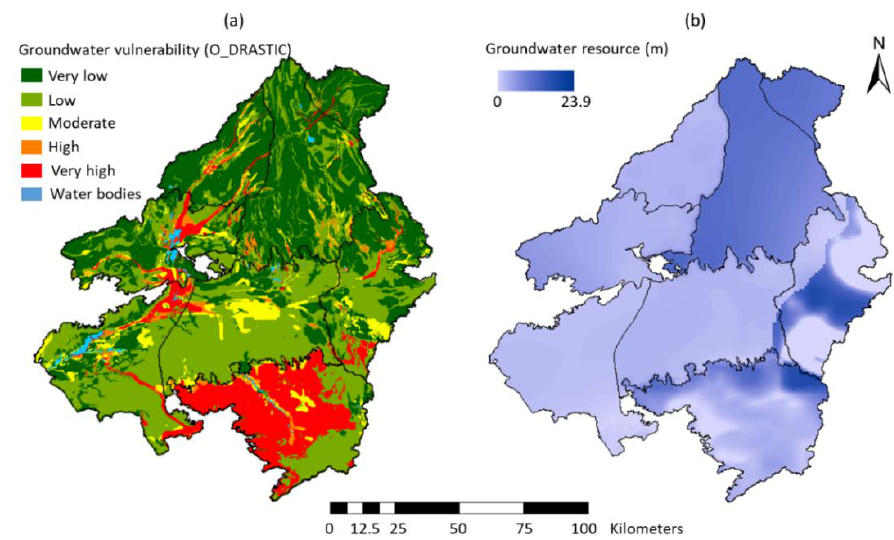
Figure 3. ( a ) Groundwater vulnerability map (O-DRASTIC) and ( b ) mean historical groundwater resource (m).